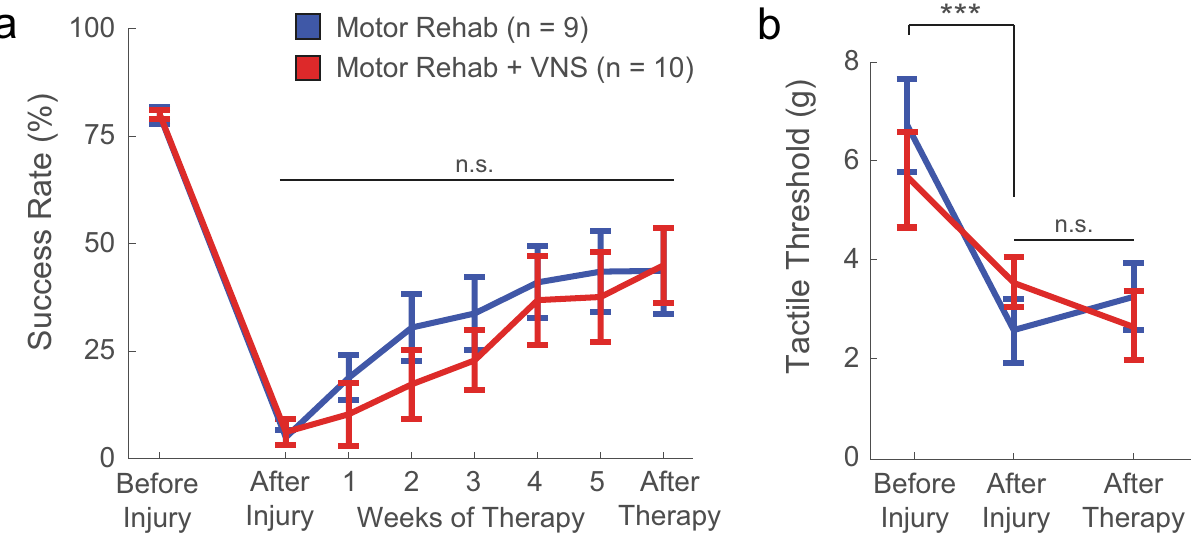
Figure 2. VNS paired with motor rehabilitation fails to improve recovery of skilled forelimb function. ( a ) Radial nerve injury results in chronic forelimb weakness, indicated by a sustained reduction in success rate on a skilled forelimb motor task. VNS paired with rehabilitative training (Motor Rehab + VNS, n = 8) fails to improve recovery of motor function compared to equivalent rehabilitative training without VNS (Motor Rehab, n = 8). ( b ) Additionally, VNS paired with motor training also fails to improve recovery of forelimb withdrawal thresholds. Data presented as mean ± SEM. *** denotes p < 0.001 at the indicated timepoints; n.s. denotes